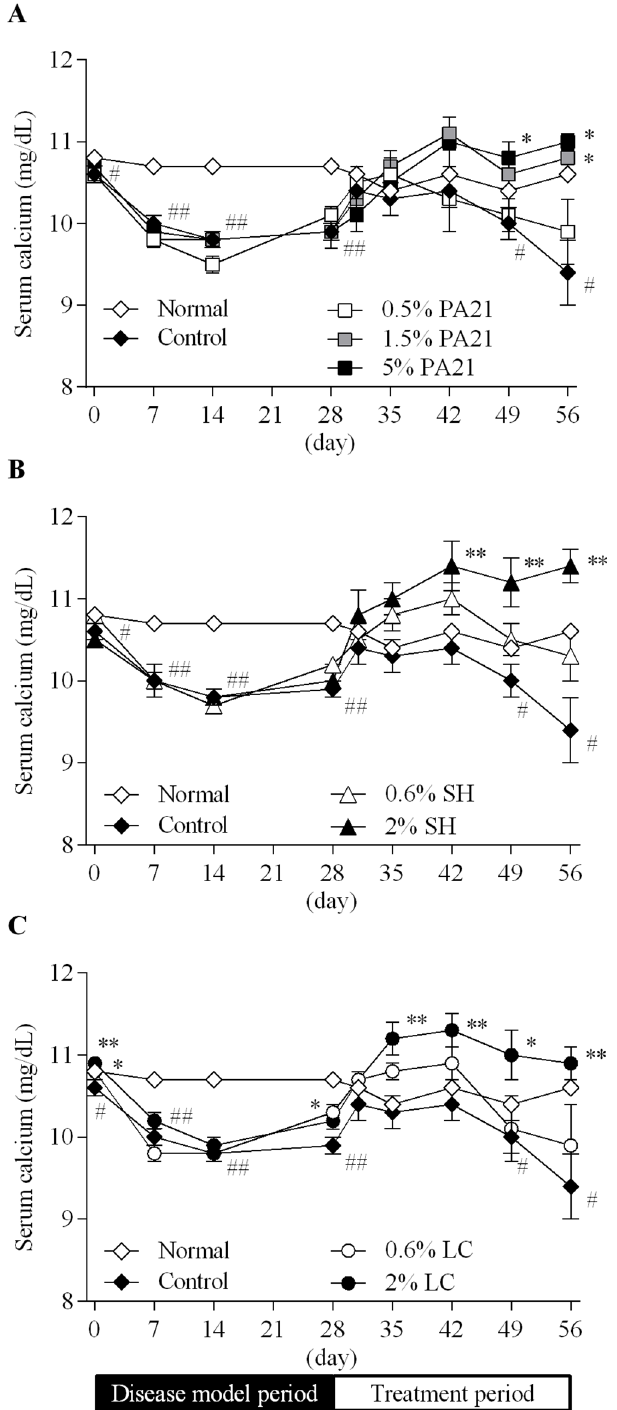
Fig 3. The effects of (A) PA21, (B) sevelamer hydrochloride, and (C) lanthanum carbonate hydrate on serum calcium level. At day 29, administration of the investigated drugs was started. Each dot in the figures shows the mean value ± standarderror of eight to 10 animals. SH, sevelamer hydrochloride; LC, lanthanum carbonate hydrate. # P < 0.05 and ## P < 0.01, Student’s or Aspin-Welch’s t-test between the normal and control groups. * P < 0.05 and ** P < 0.01, Dunnett’s or Steel’s multiplecomparisontests betweenthe control and the investigateddrug administeredgroups.